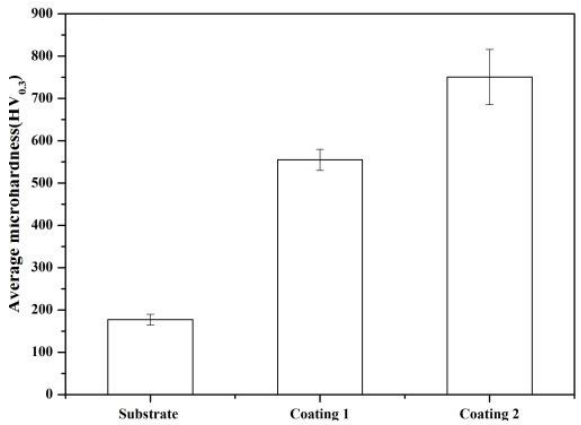
Figure 14. Microhardness profiles of transverse cross-sections of the composite coatings.